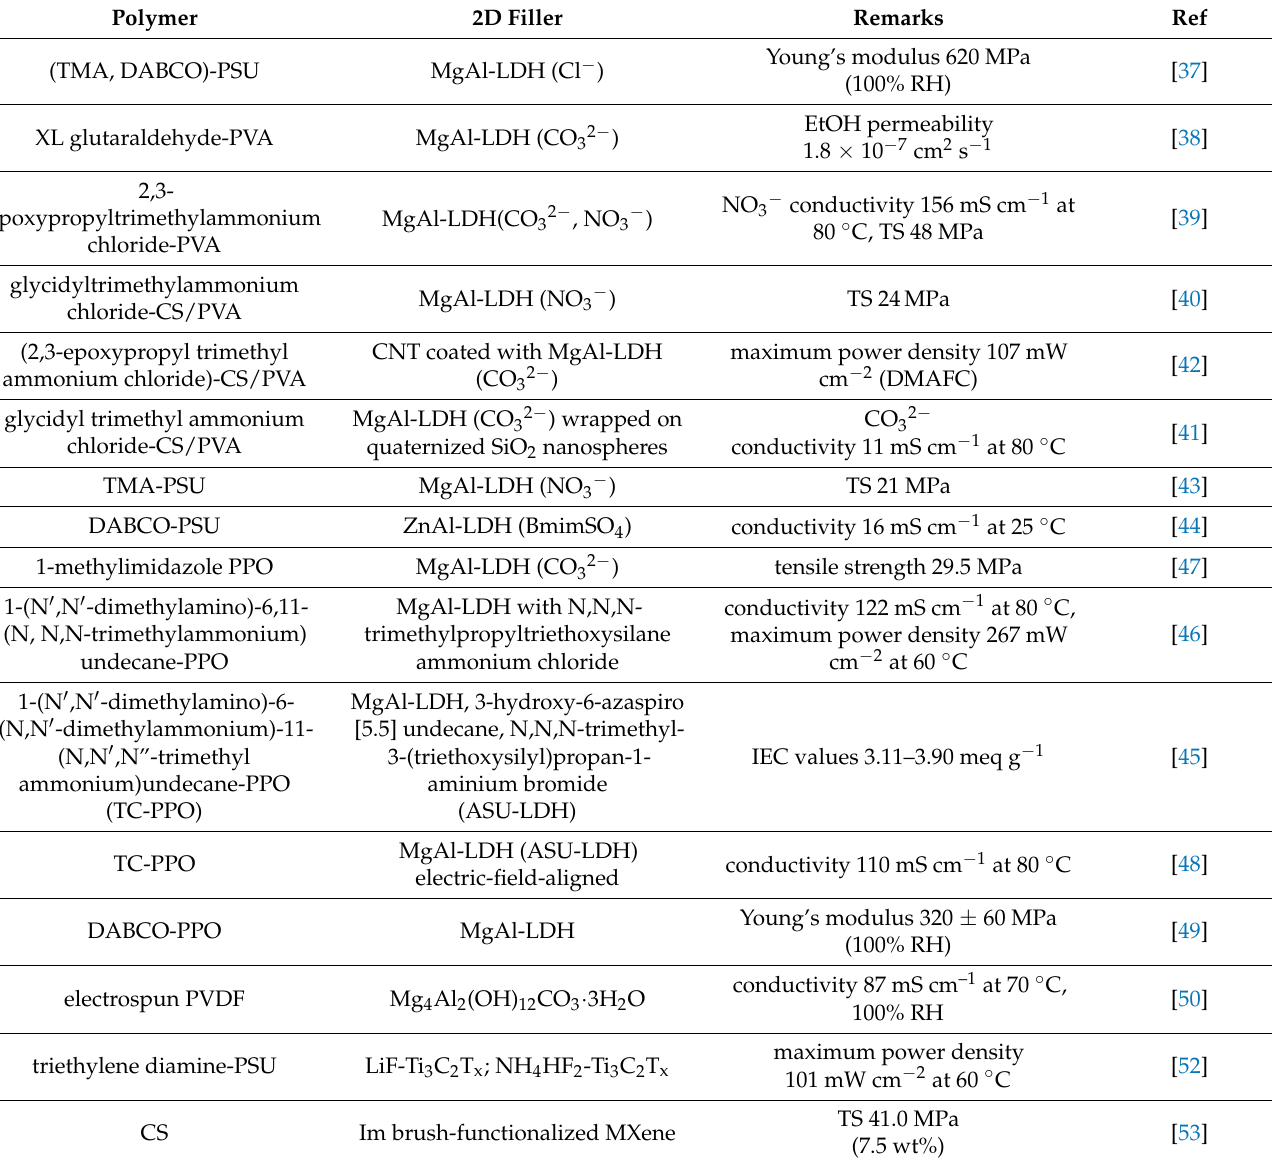
Table 2. Type of polymer and 2D filler in composite AEM with LDH or